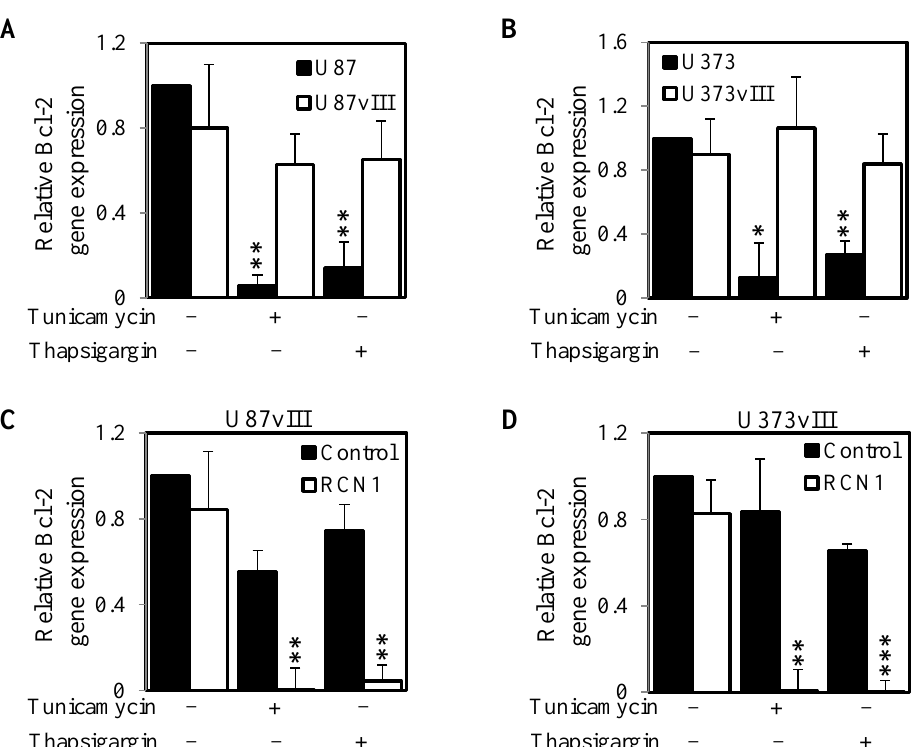
Figure 7. RCN1 expression prevents reduction in Bcl-2 gene expression. ( A ) U87 and U87vIII and ( B ) U373 and U373vIII cells were seeded and allowed to adhere overnight. Cells were then treated with ± tunicamycin (50 nM) or ± thapsigargin (50 nM) for a further 24 h, then lysed and assessed for Bcl-2 gene expression by qPCR. Similarly, ( C ) U87vIII and ( D ) U373vIII cells were transfected with either control or RCN1 siRNA and allowed to adhere overnight. Cells were then treated with ± tunicamycin (50 nM) or ± thapsigargin (50 nM) for a further 24 h, lysed and assessed for Bcl-2 gene expression by qPCR luciferase activity. Data are expressed as relative Bcl-2 gene expression (fold change) by standardizing the Bcl-2 gene expression of the control untreated cells to 1, and accordingly normalizing all other raw values. * p < 0.05; ** p < 0.01; *** p < 0.001.